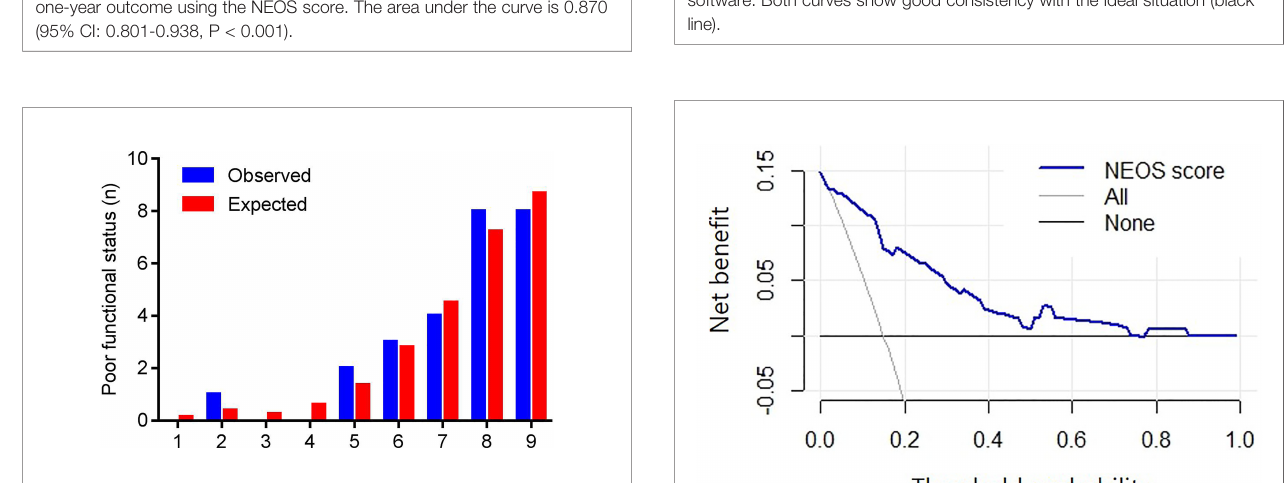
FIGURE 3 | The results of the Hosmer-Lemeshow test. Patients were grouped based on the fi tting probabilities (x axis). The blue column represents observed events (poor outcome at one year), and the red column represents predicted events of the NEOS score. There were no signi fi cant differences between observed and expected events (P = 0.912).